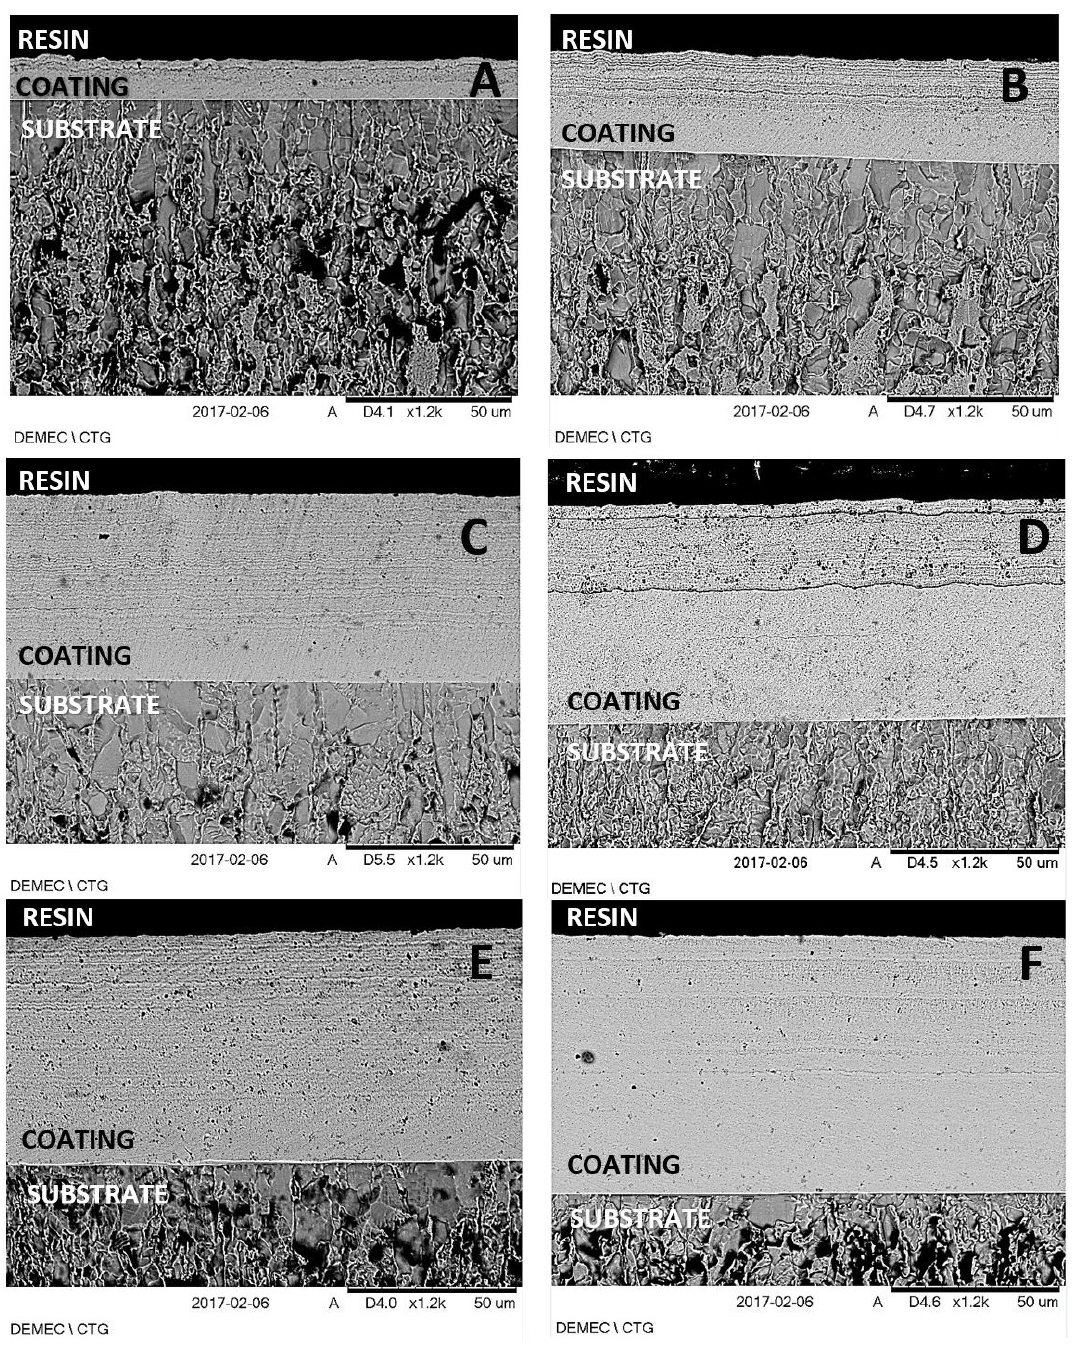
Figure 5. SEM micrographs of the cross-section of Ni-Co/SiC nanocomposite coatings, obtained under the cathodic current condition 5.5 A dm -2 in the intervals: A) 10 min; B) 20 min; C) 30 min; D) 40 min; E) 50 min; F) 60 min. Etching: 1: 1 HNO solution for 5